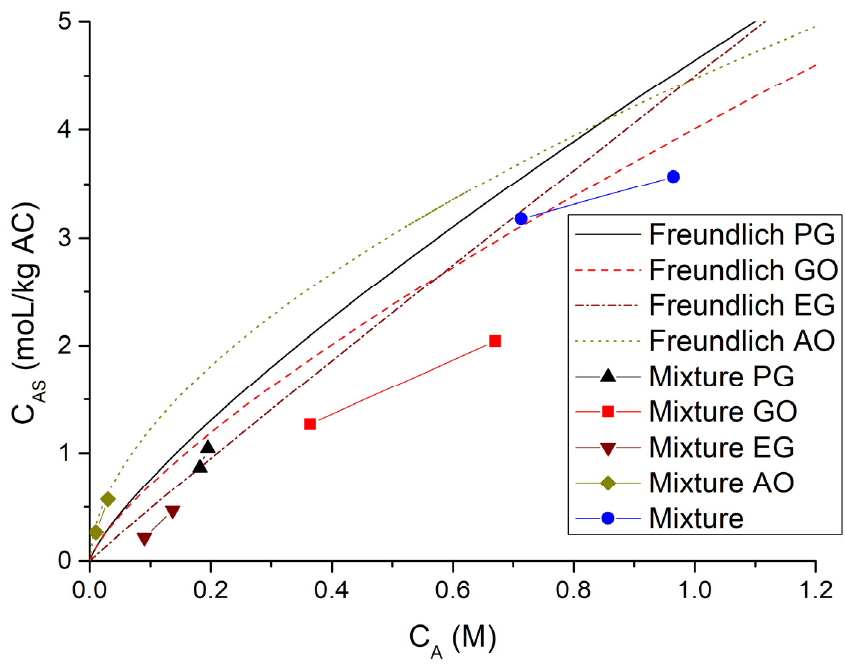
Figure 4. Comparison of the adsorption in mixture vs. the Freundlich model.